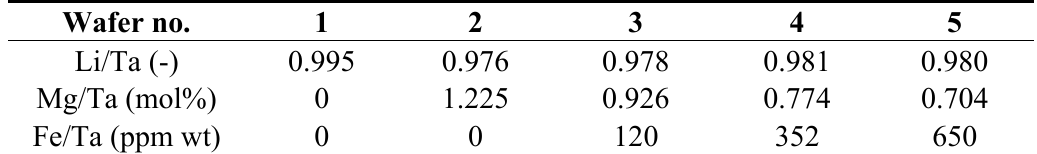
Table 2. Composition of the grown crystals measured by ICP-AES